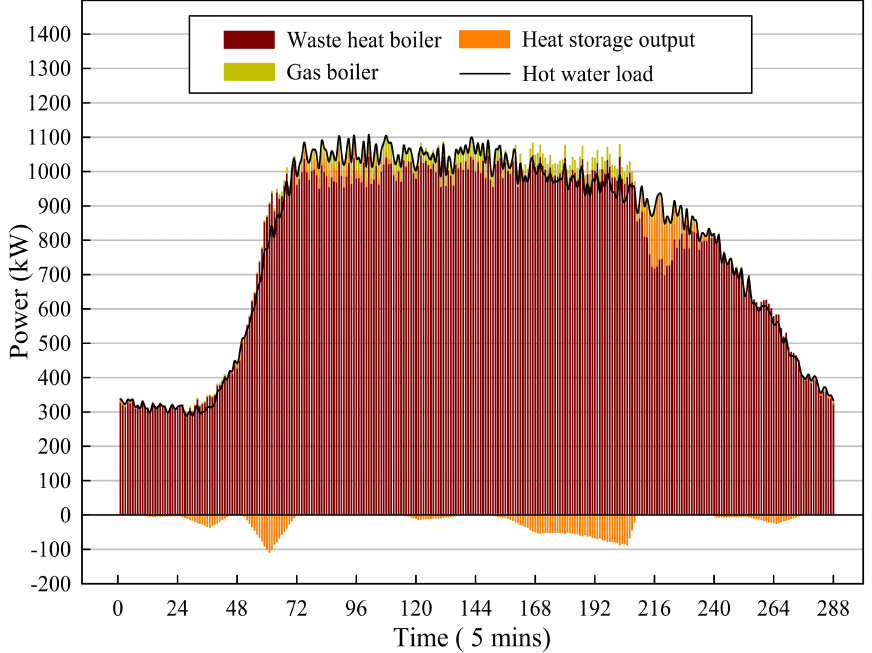
Figure 10. Real-time balance curve of hot water load.